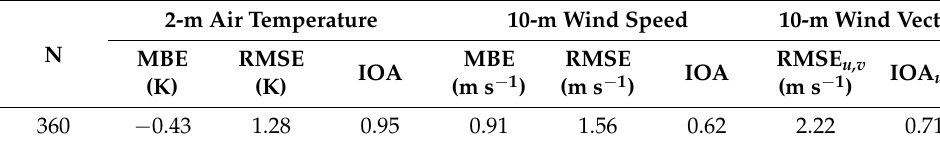
N Figure 3. Mean diurnal variation of observed (OBS) and simulated (MOD) near-surface ( a ) air temperature ( T s ; K) and ( b ) wind speed ( WS s ; m s –1 ) averaged at 15 AWS/ASOS stations in D04 on 15 July 2018.